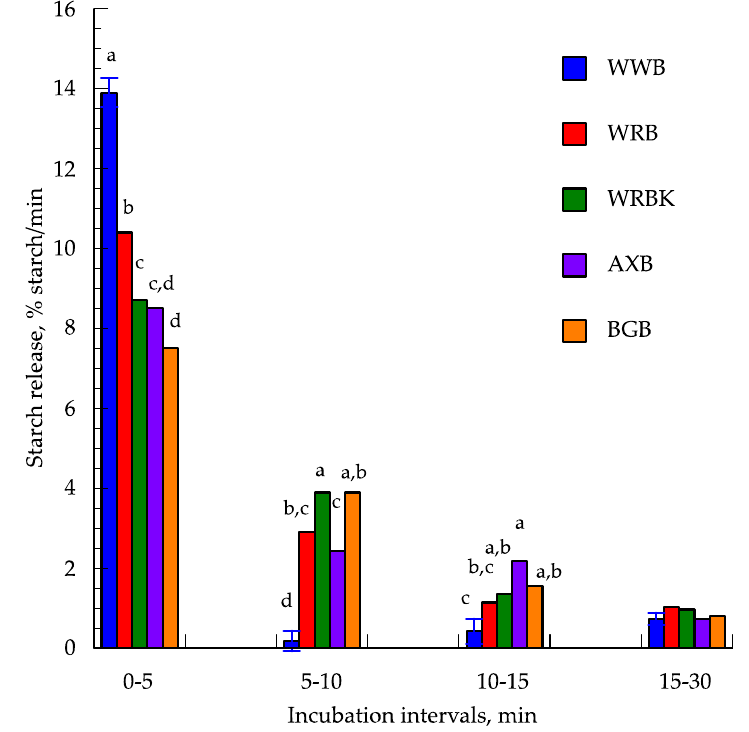
Figure 3. In vitro starch hydrolysis (% of total starch/min) in different time intervals of the white wheat bread (WWB), whole grain rye bread (WRB), whole grain rye bread with kernels (WRBK), arabinoxylan bread (AXB) and the beta-glucan bread (BGB). Values are the means ± SEM ( n = 3); a, b, c, d mean values with different superscript letters were significantly different.